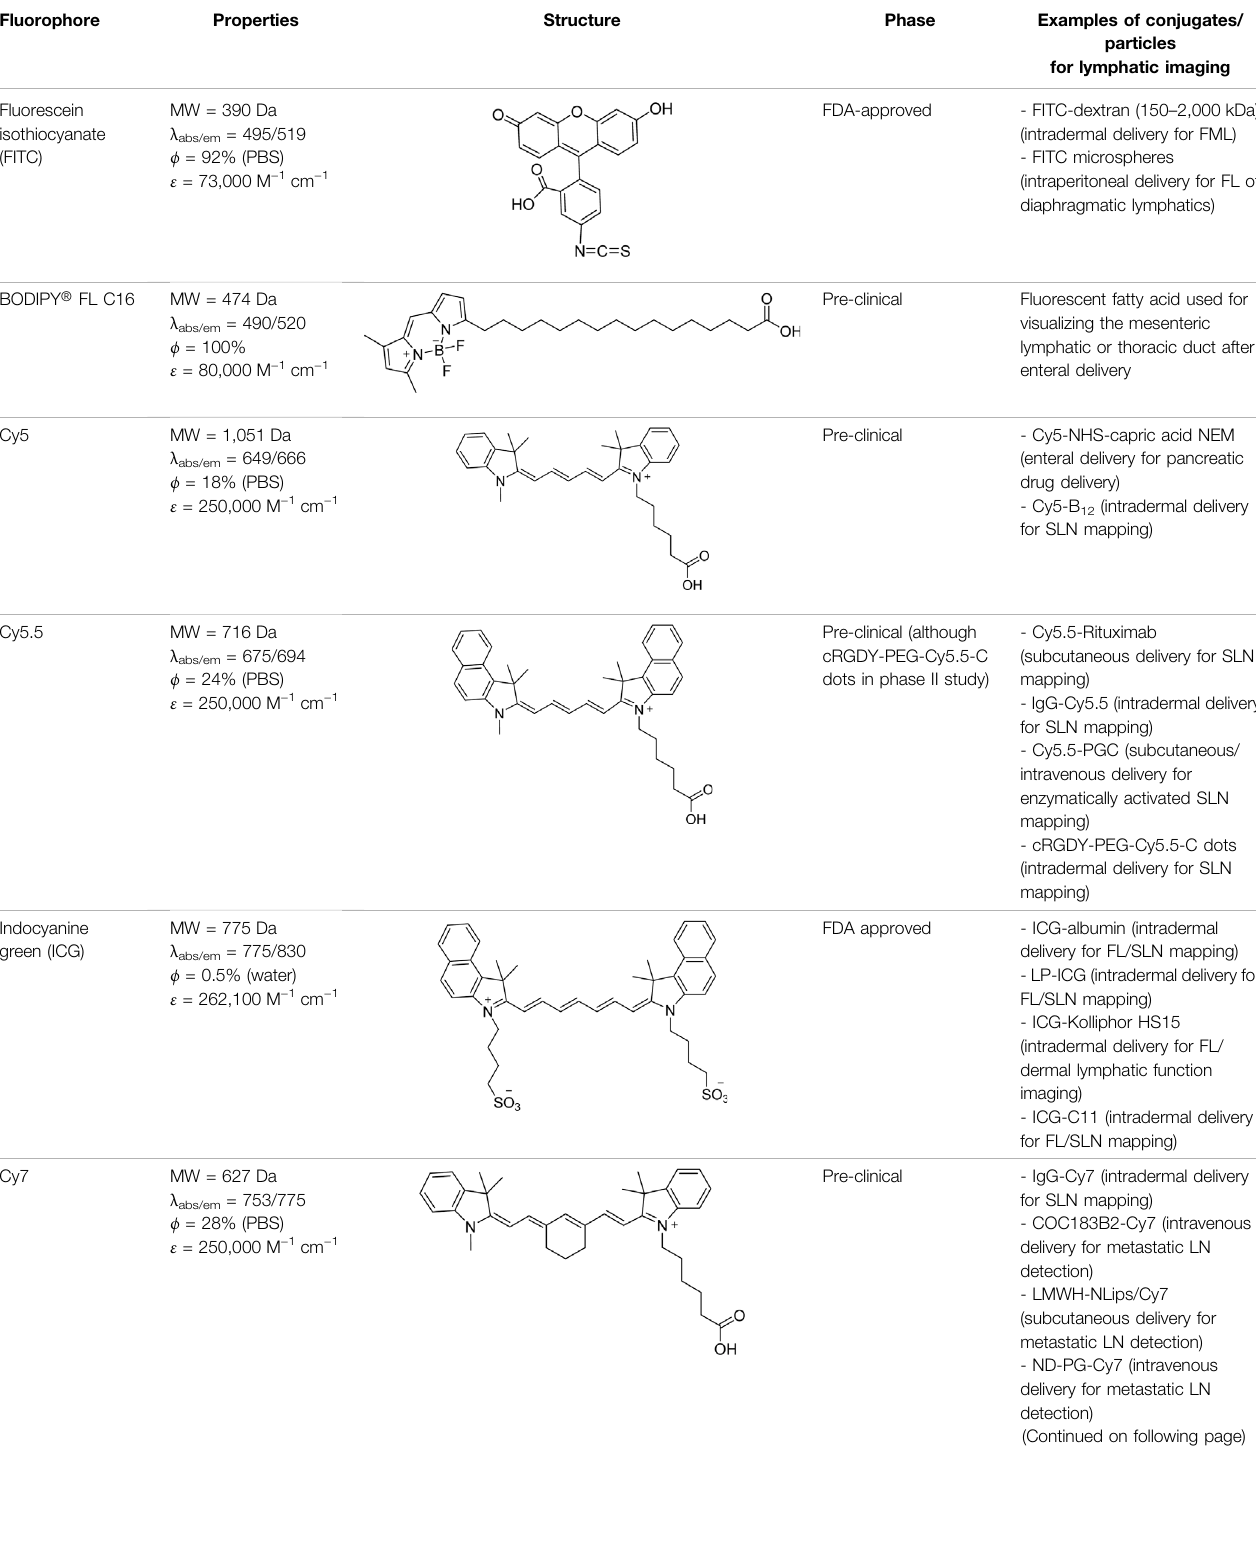
TABLE 2 | Common fl uorescent tracers used for lymphatic